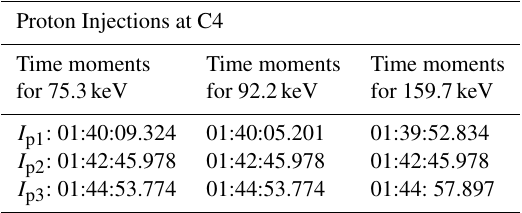
Table 3. Time moments of proton injections observed by C4 during